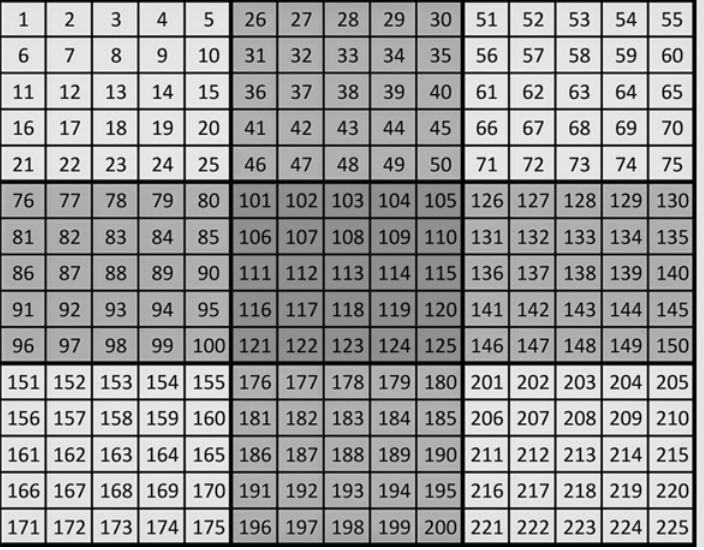
Fig 4. Raster implementation of regions and spatial neighborhoods. In this example, region in the center is neighbor to the four rook neighbors in light gray.